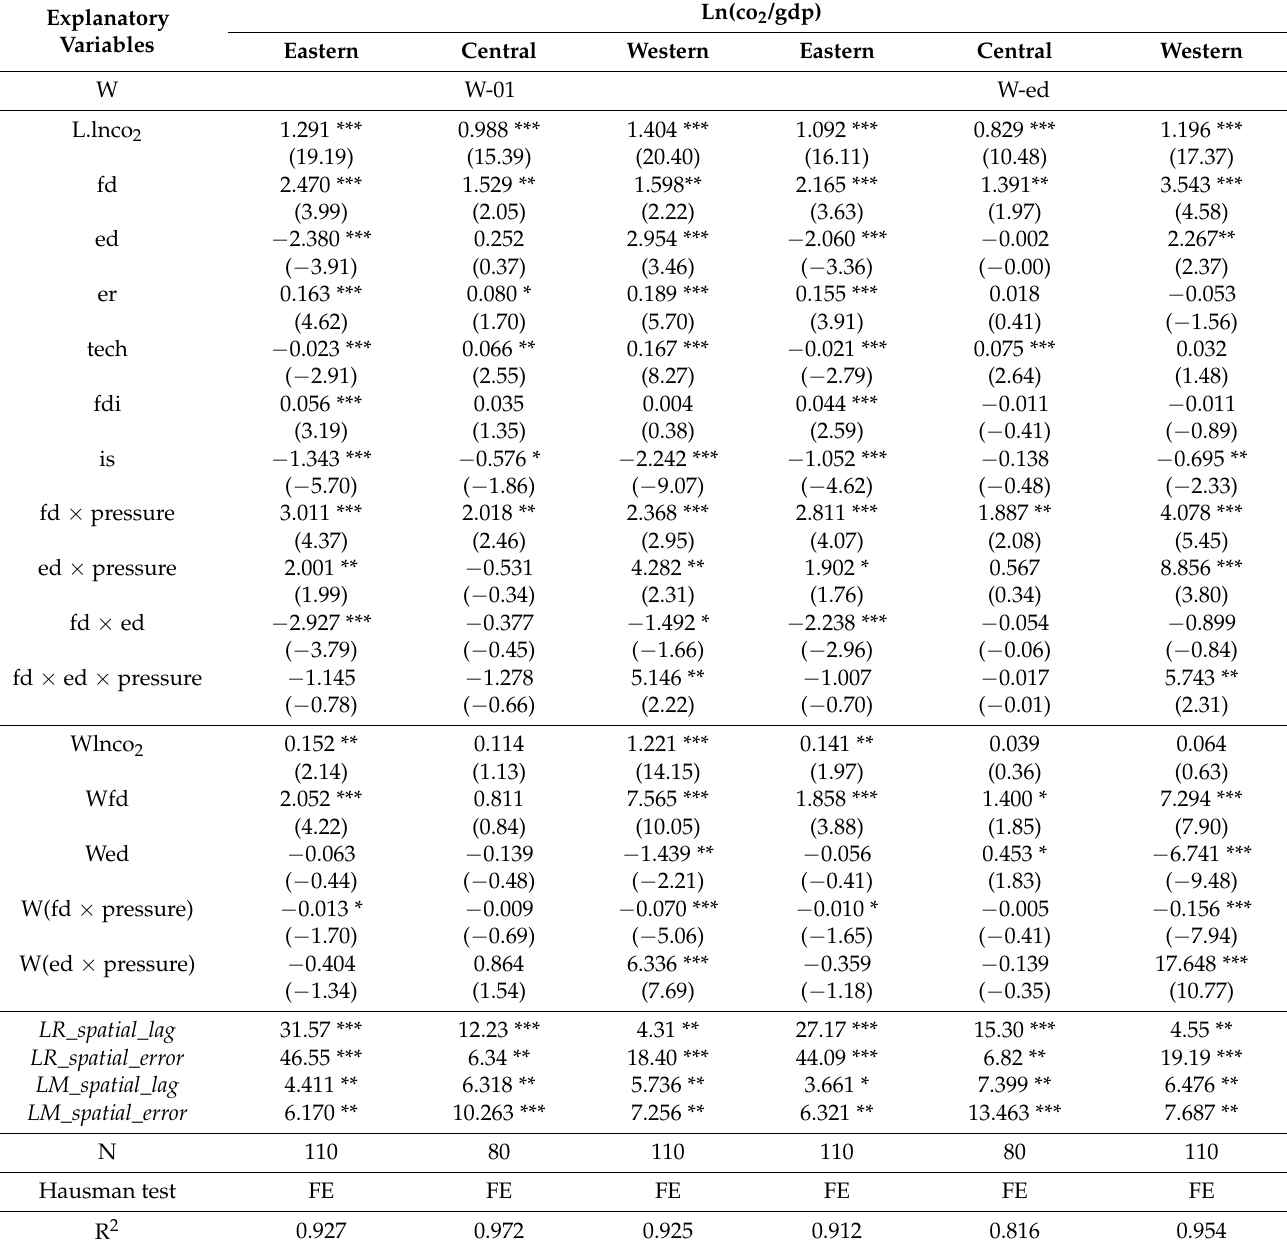
Table A1. Regression estimates of fiscal and environmental decentralization and carbon emissions by